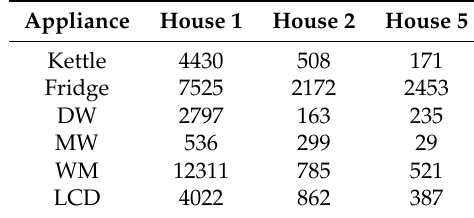
Table 1. The number of appliance events per house in UK Domestic Appliance-Level Electricity dataset (UK-DALE).